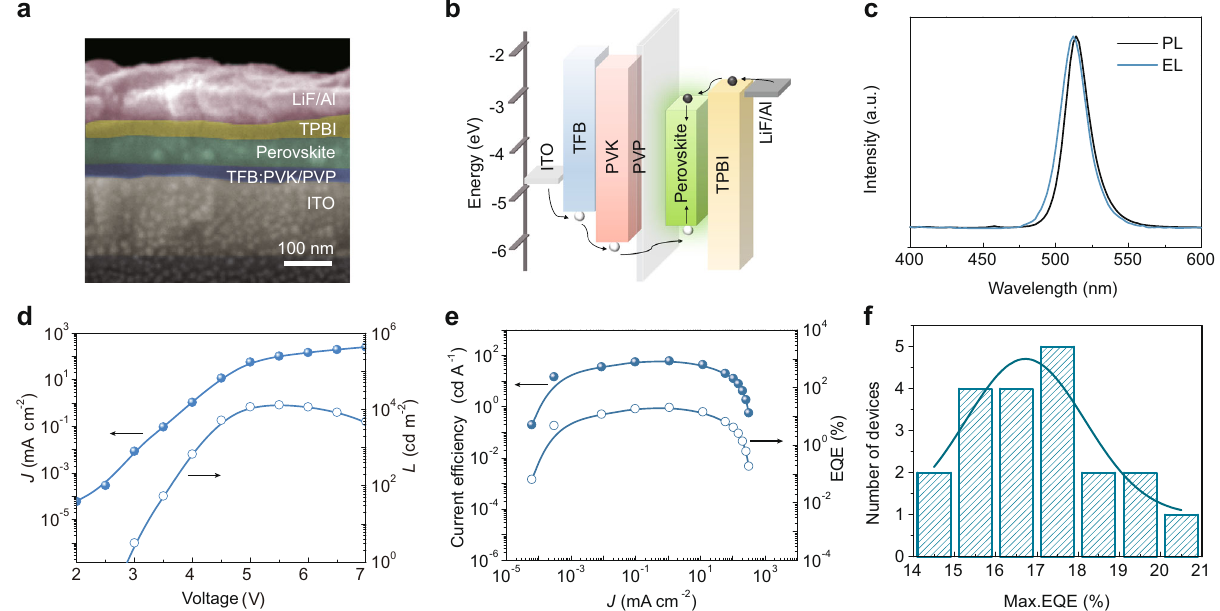
Fig. 5 Device structure and performance of PeLEDs. a Cross-sectional SEM image of a PeLED with a structure of ITO/TFB:PVK (25 nm)/PVP (4 nm)/ perovskite (50 nm)/TPBI (35 nm)/LiF (1 nm)/Al (100 nm), and b its schematic energy band diagram. Except for the perovskite layer which is directly measured, the energy level values for the other functional layers are taken from Lu et al. 11 . c Normalized PL spectrum of the 8%-MeS fi lm, and EL spectrum of the PeLEDs at an applied voltage of 5.5 V. d J – V – L , e CE – J – EQE curves of the best-performing 8%-MeS-treated PeLED, and f histogram of the maximum EQEs measured on 20 such Exciton energy transfer manipulation for ef fi cient PeLEDs . Green PeLEDs with structures of ITO/TFB:PVK/control perovskite/1,3,5-tris(1-phenyl-1H-benzimidazol-2-yl)benzene (TPBI)/lithium fl uoride (LiF)/aluminum (Al) (Device A), ITO/ TFB:PVK/MeS-treated perovskite/TPBI/LiF/Al (Device B), ITO/ TFB:PVK/PVP/MeS-treated perovskite/TPBI/LiF/Al (Device C),